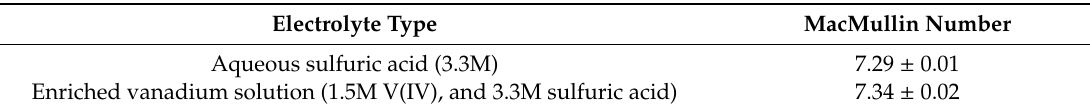
Table 2. MacMullin number for IEMs within VRFBs configuration.